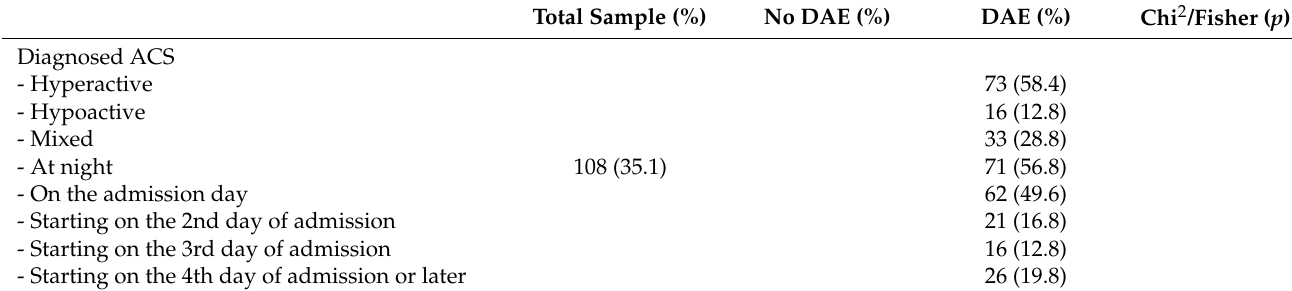
Table 3. The characteristics of ADE and the presence of precipitating factors in the development of